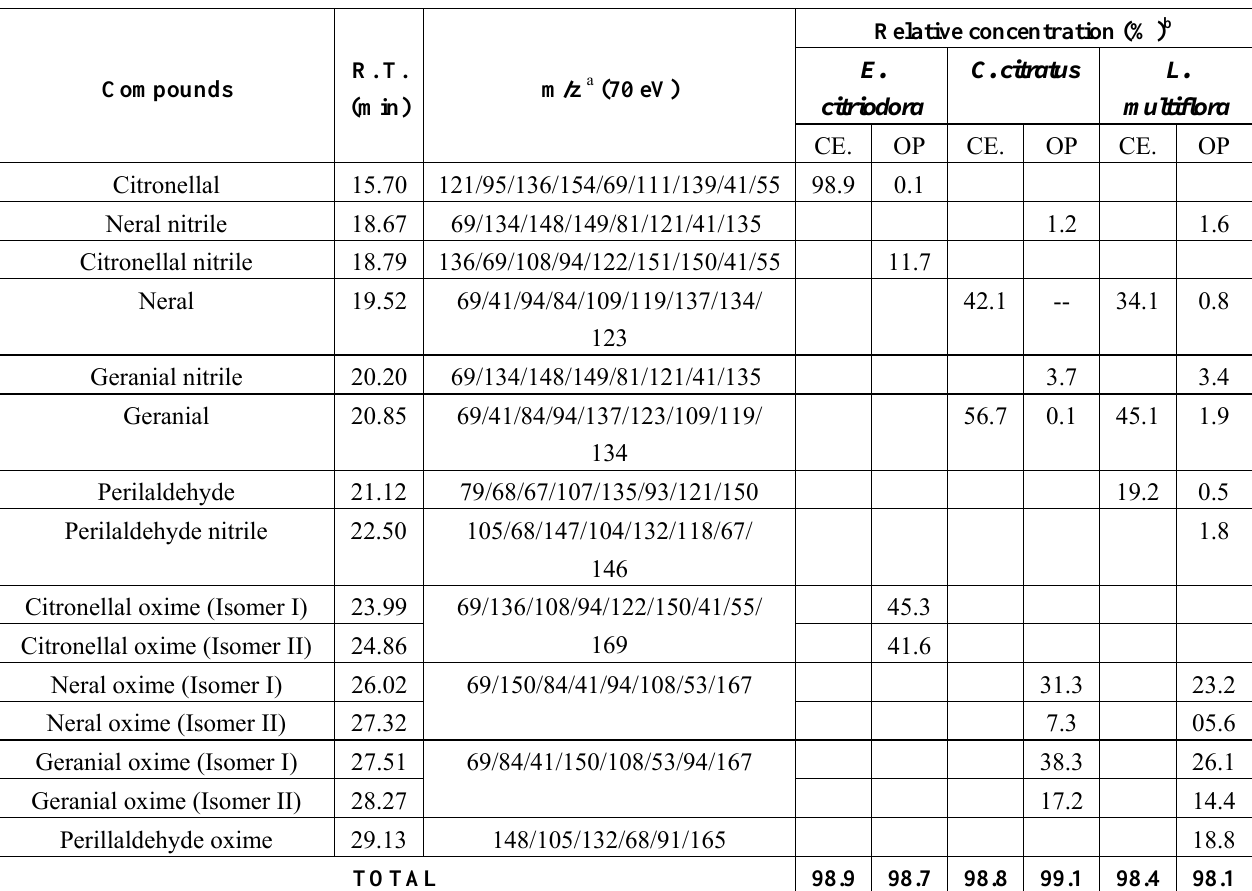
Table 2 . Chemical constituents of oximation products (OP) obtained from carbonyl extracts of E. citriodora, C. citratus, L. multiflora treated by hydrochloride hydroxylamine.